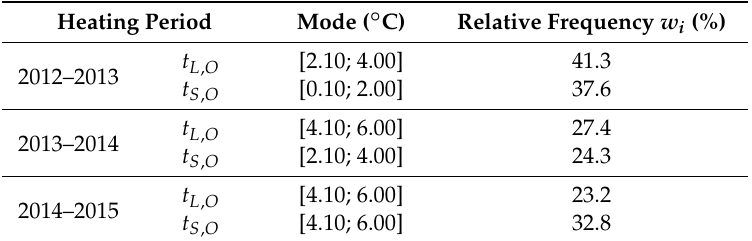
Table 3. Mode and temperature frequencies t L , O , t S , O of the ground mass in the proximities of